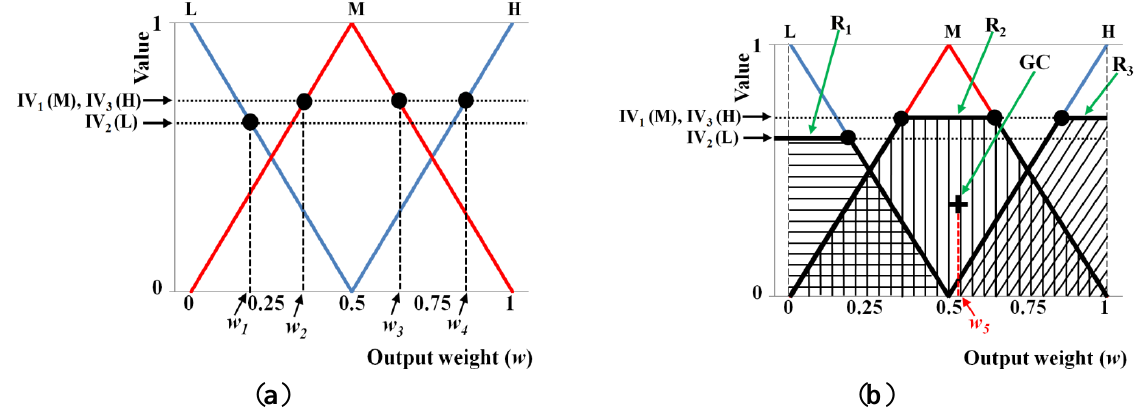
Figure 14. Illustration of the defuzzification methods used: ( a ) FOM, LOM, MOM, and MeOM; and ( b )